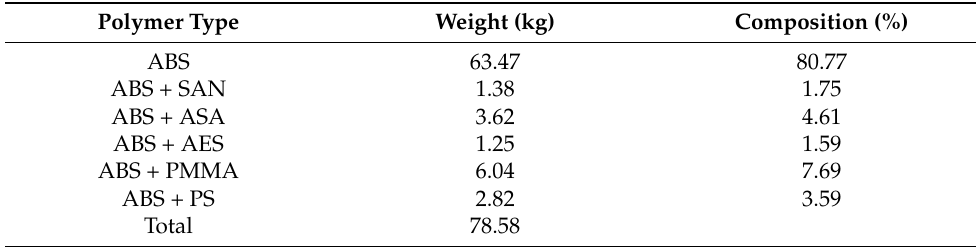
Table 2. Composition of recycled polymers.